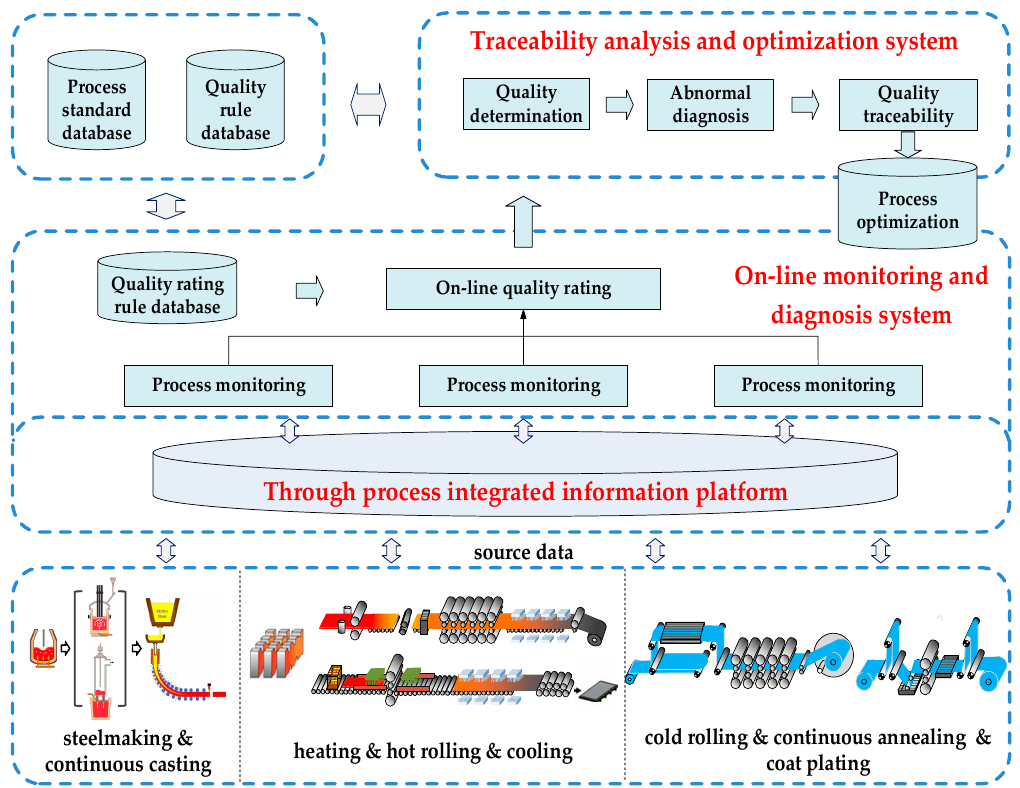
Figure 2. On-line monitoring, diagnosis and optimization technology of product quality in the through process.